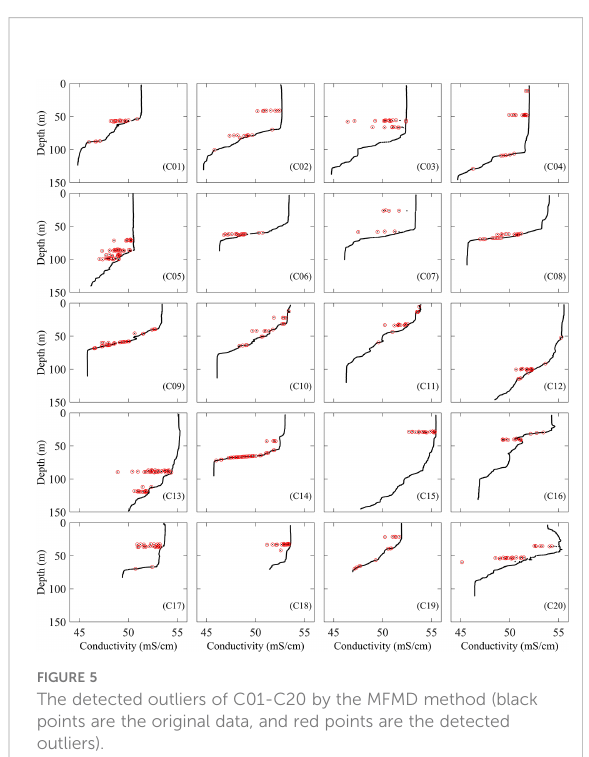
FIGURE 5 The detected outliers of C01-C20 by the MFMD method (black points are the original data, and red points are the detected outliers).